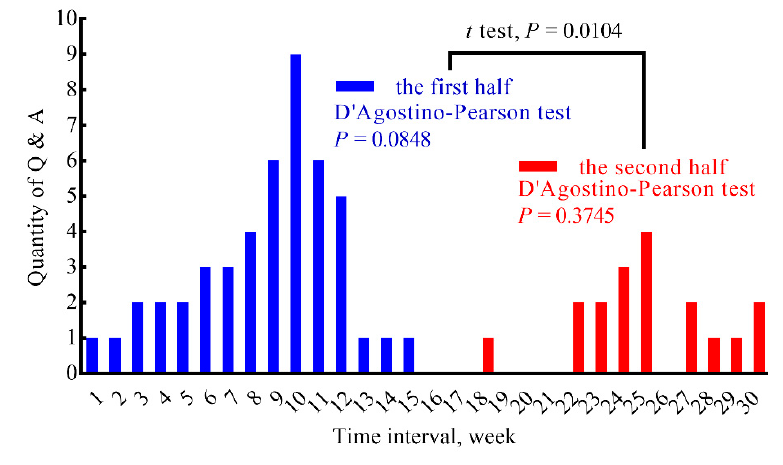
Figure 6. Trend in the quantities of Q&A on root rot disease of strawberr y .